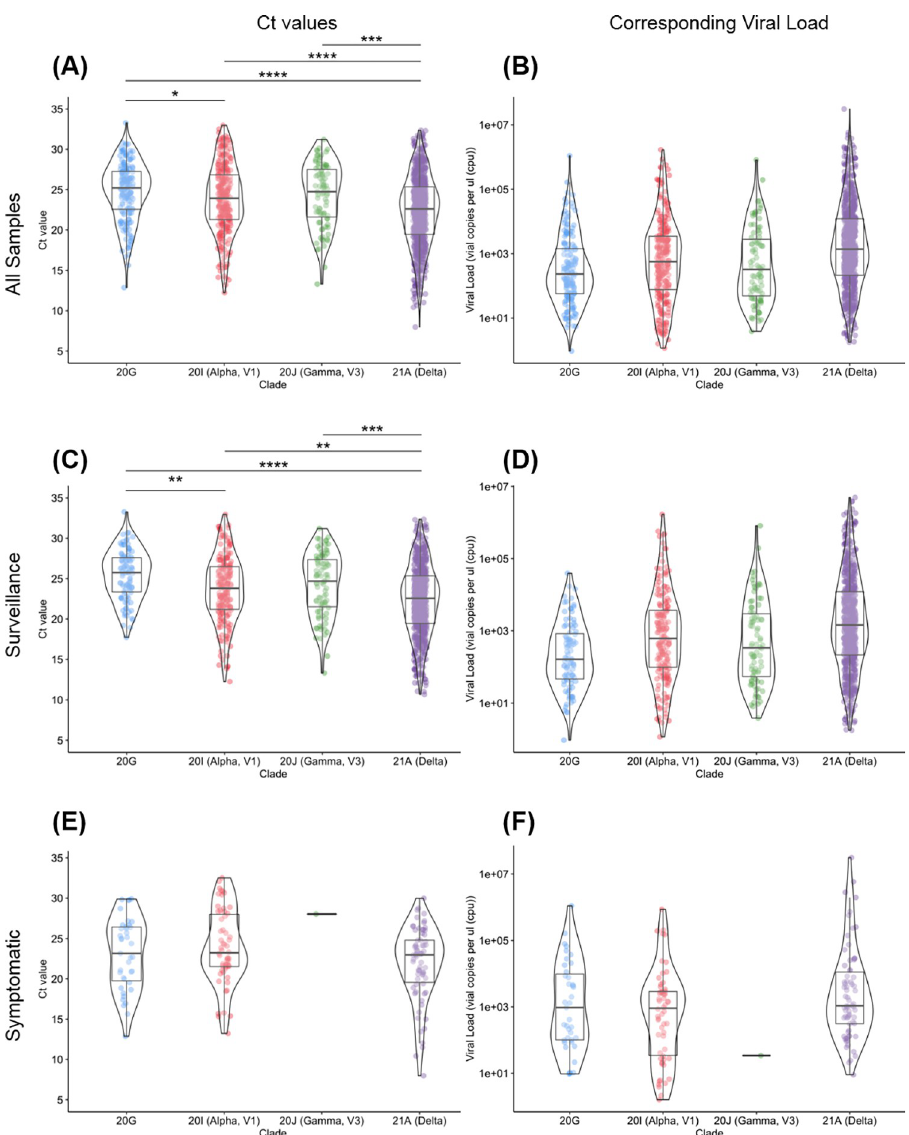
Fig 2. Measured N1 Ct values (left) and corresponding calculated viral loads (right) of common clades in saliva. We analyzed the Ct values from a total of 1297 SARS-CoV-2 positive saliva samples, using the N gene target. 2A and 2B: Comparison of all samples. Delta (n = 787) showed a statistically significant difference in Ct value when compared to 20G (n = 159), Alpha (n = 258), and Gamma (n = 87). 2C and 2D: Comparison of surveillance samples. When only surveillance samples were considered, the same trends were observed, showing a significant difference between Delta (n = 691) and all other clades (20G: n = 95, Alpha: n = 181, Gamma: n = 86). Both groups also showed a significant difference when comparing Alpha and 20G. 2E and 2F. Comparison of symptomatic samples. There were no significant differences in Ct values observed among symptomatic samples for Delta (n = 70), Alpha (n = 58), Gamma (n = 1), and 20G (n = 39). � p.adj < 0.05, �� p.adj < 0.01, ��� p.adj < 0.001, ���� p.adj <